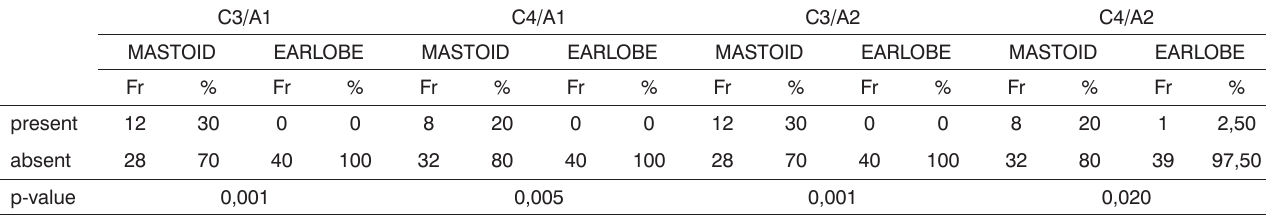
Table 6. PAR occurrence distribution in MLEAP, both in the Mastoid and the Earlobe, for the C3/A1, C4/A1, C3/A2 e C4/A2